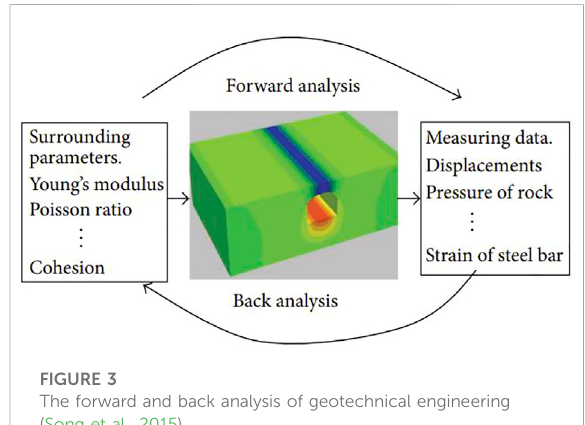
FIGURE 3 The forward and back analysis of geotechnical engineering (Song et al.,